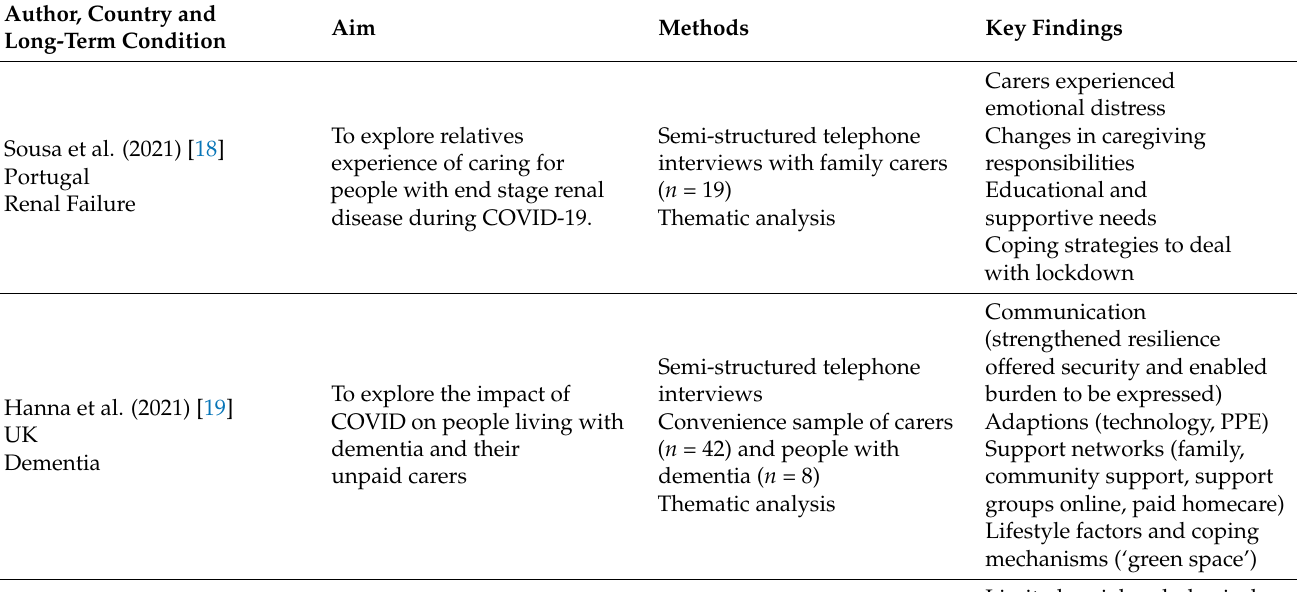
Table 3. Summary of study